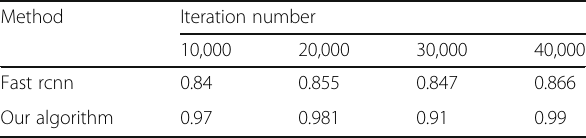
Table 2 The mAP with different iteration time